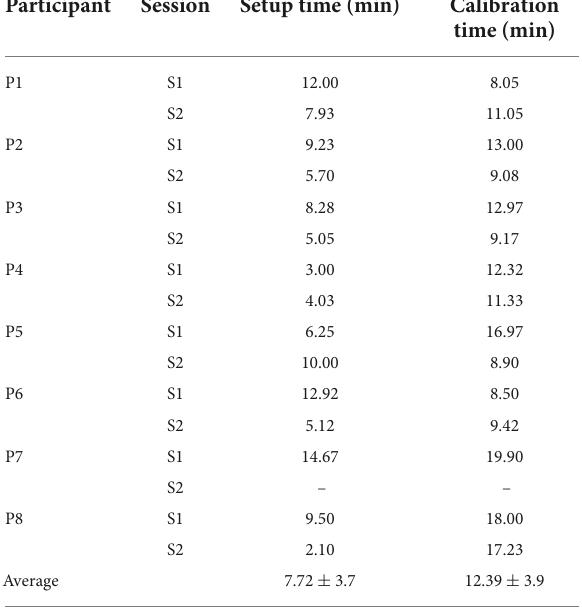
TABLE 3 Brain-computer interface setup and calibration